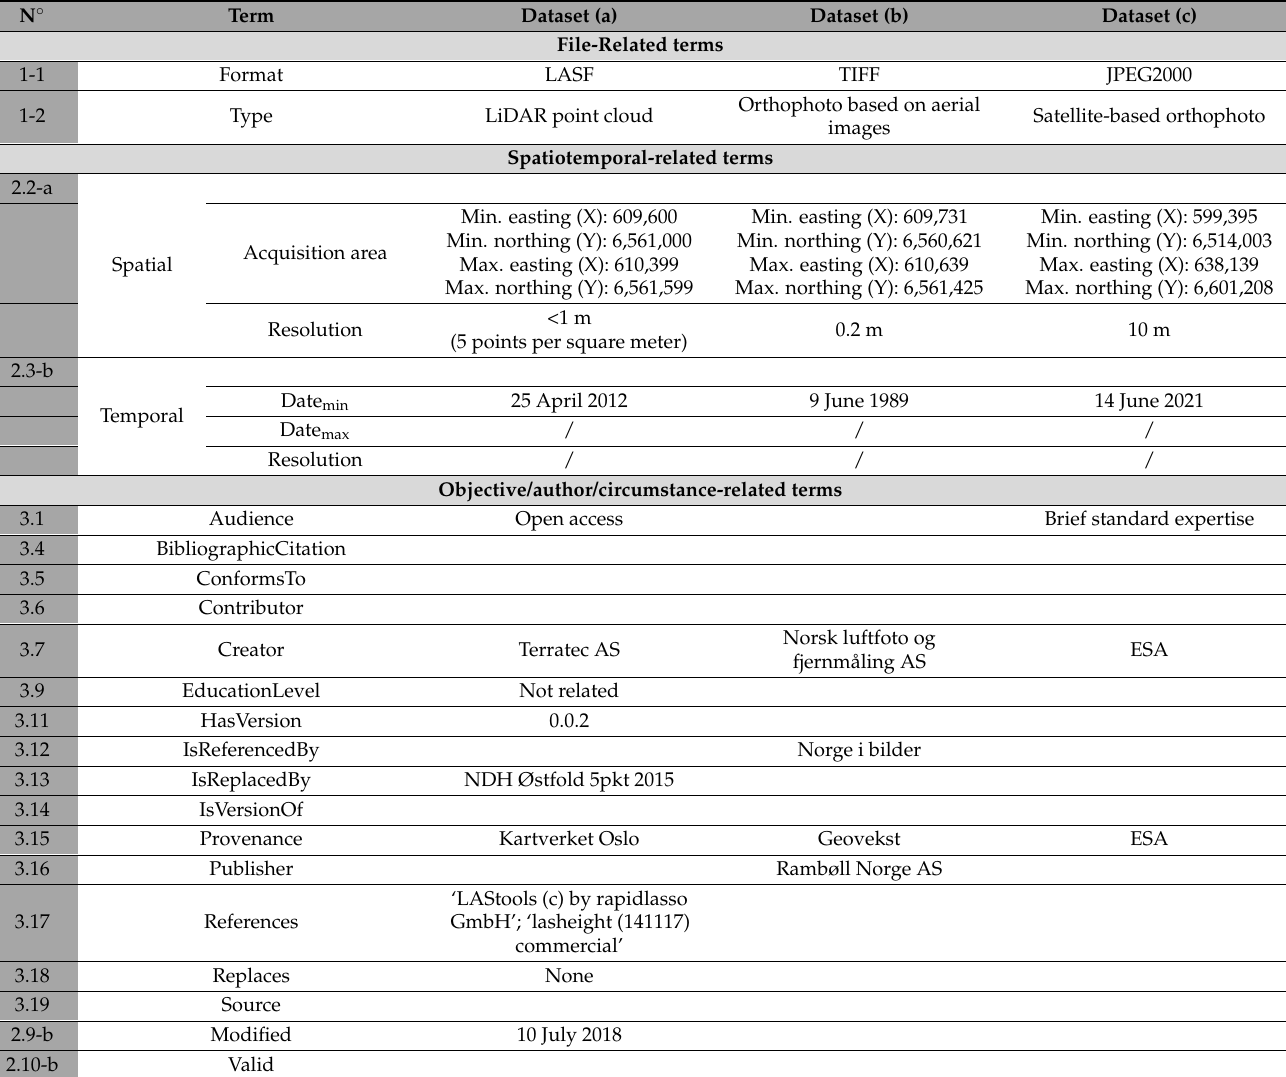
Table 19. DC-like terms for the three simulated